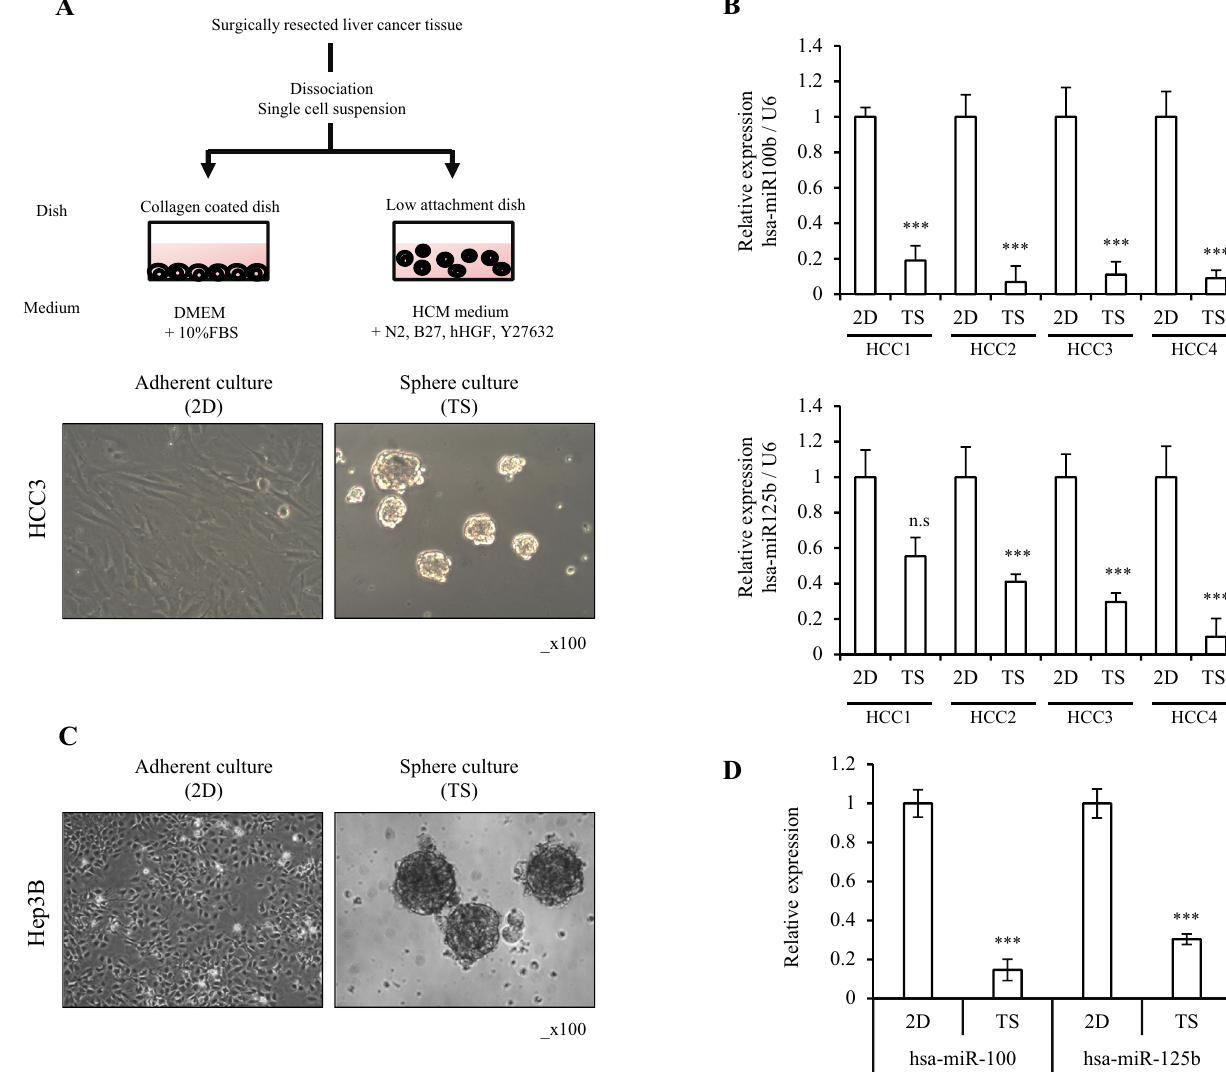
Figure 1. Lower expression of miR-100 and miR-125b in hepatocellular carcinoma stem cells (CSCs). ( A ) Schematic process of establishment of tumorsphere (TS) and two-dimensionally as adherent cells (2D). Hepatocellular primary cancer cells derived from patients were cultured in ultra-low attachment dishes with CSC culture medium for 7 days to enrich CSCs, as shown in the Materials and Methods. The spheres formed under the CSC culture condition, as well as monolayer cells cultured in collagen type 1 coated dishes. ( B ) Reduced expression of miR-100 and miR-125b in tumorsphere (TS) cells was quantified with specific TaqMan probe using qRT-PCR. miR-100 and miR-125b expression decreased significantly in TS cells compared with adherent cells (2D). ( C ) Hep3B formed TS under the CSC culture condition in the low attachment dish. ( D ) miR-100 and miR-125b levels were quantified with TaqMan probe using qRT-PCR in Hep3B TS cells and 2D cells. Relative expression was calculated using U6 expression as an internal control. The average (column) ± SD (bar) is indicated ( *** p < 0.001, n.s, not